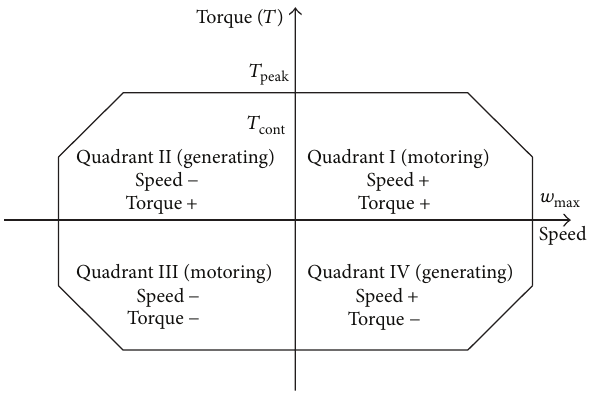
Figure 1: Torque versus speed motoring and generating quadrants (adopted from [2]).